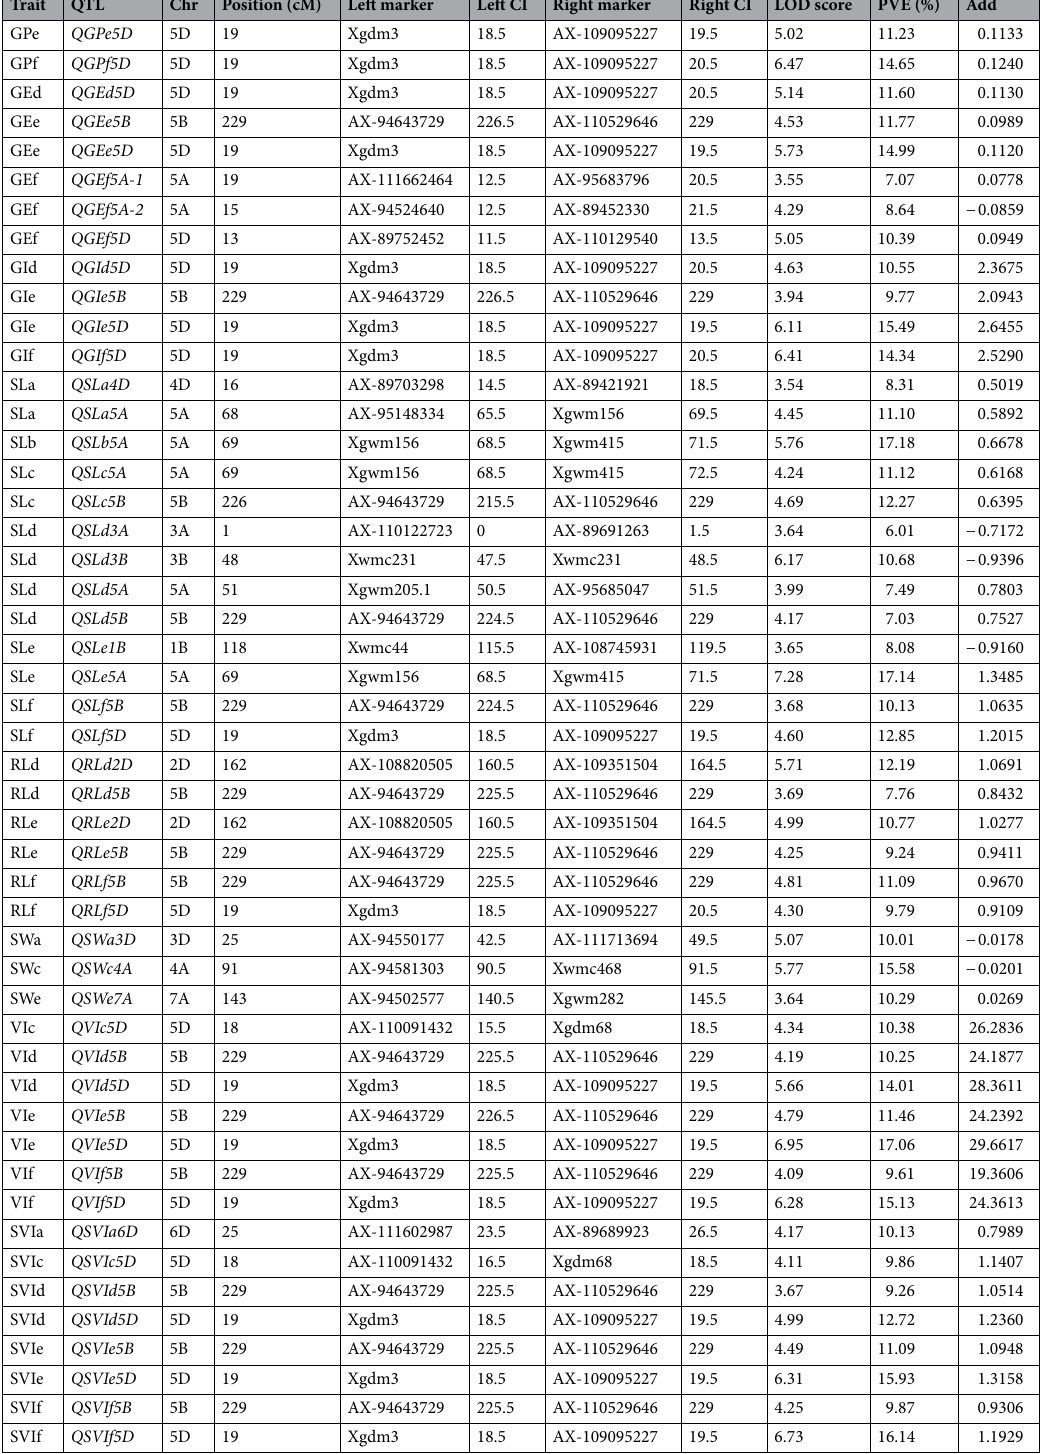
Table 1. Additive QTLs for seed vigor traits in wheat DH lines using the ICIM method. GP, GE, GI, SL, RL, SW, VI, SVI = Germination Percentage, Germinating Energy, Germination Index, Seedling Lengh, Root Length, Seedling Weight, Vigor Index, and Simple Vigor Index, respectively. PVE = percentage of phenotypic variance explained by the QTL, Add = additive effect. a, b, c, d, e, and f represent aging for 0 h, 24 h, 36 h, 48 h, 60 h and 72 h,